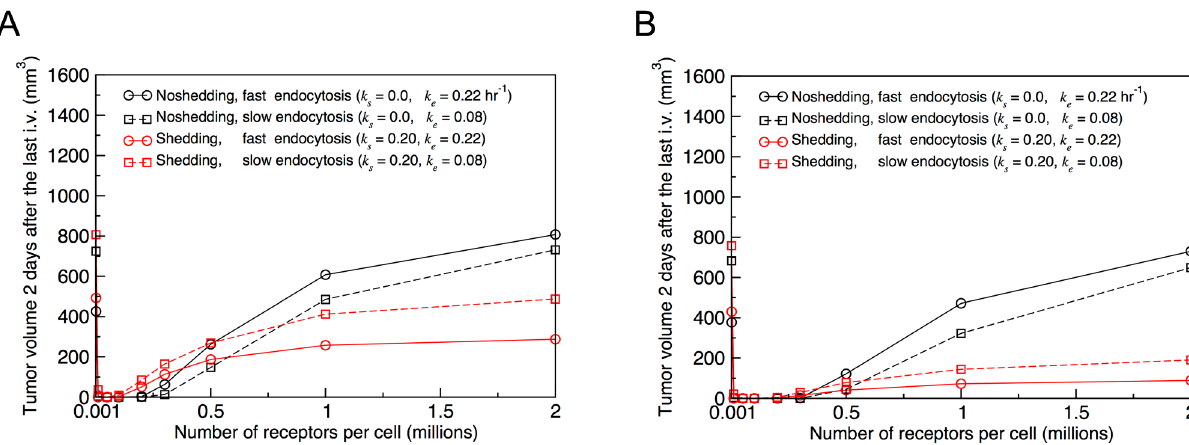
Figure 5. Predicted tumor volumes at two days after the last injection versus number of surface antigen molecules per cell ( R *) for the A431/H9 cell tumor with 3 6 62 nM (A) or 3 6 124 nM (B) injections of SS1P for the shedding and no shedding cases with two different endocytosis rate constants ( k e =0.08 and 0.22 hr 2 1 ).